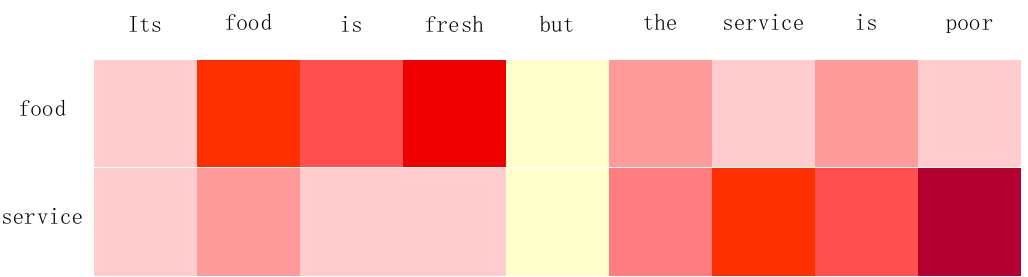
13 of 16 Figure 6. Comparison of CTI-F1 and CTI-no coefficient-F1. Figure 5 and Figure 6 show the experimental result. In CTI, when the number of layers L < 2, the Acc and F1 were increasing. When L > 2, the accuracy and F1 showed a downward trend and obtained the best results when the number of layers was equal to 2. It was probably because as the number of